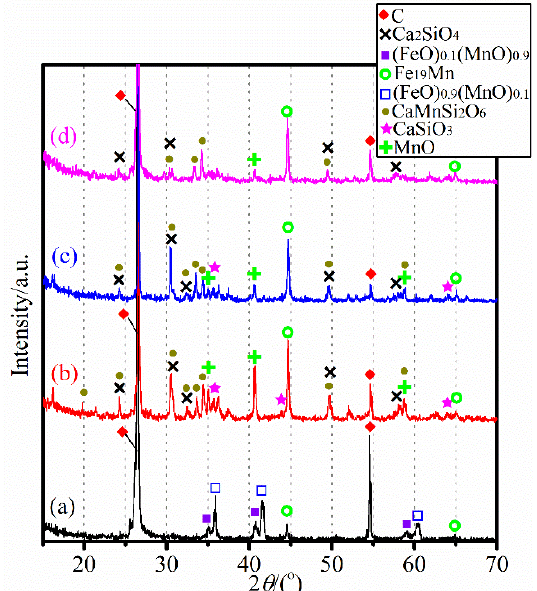
Figure 8. XRD patterns of the residues from water-leaching the products after reduction with addition of various amounts of CaCl 2 ( a , 0 wt%; b , 10 wt%; c , 20 wt%; d , 30 wt%). In the absence of CaCl 2 , carbothermic reduction was slow, forming monoxides of (FeO) 0.9 (MnO) 0.1 , (FeO) 0.1 (MnO) 0.9 and minor amounts of metallic Fe (i.e., Fe 19 Mn), as seen from Figure